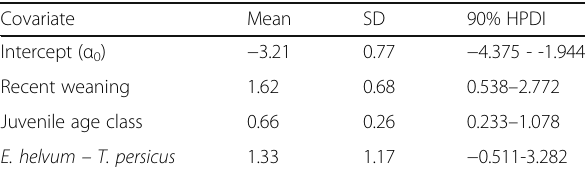
Table 2 Summary of the posterior probability distributions of the fixed-effects coefficients of the selected model